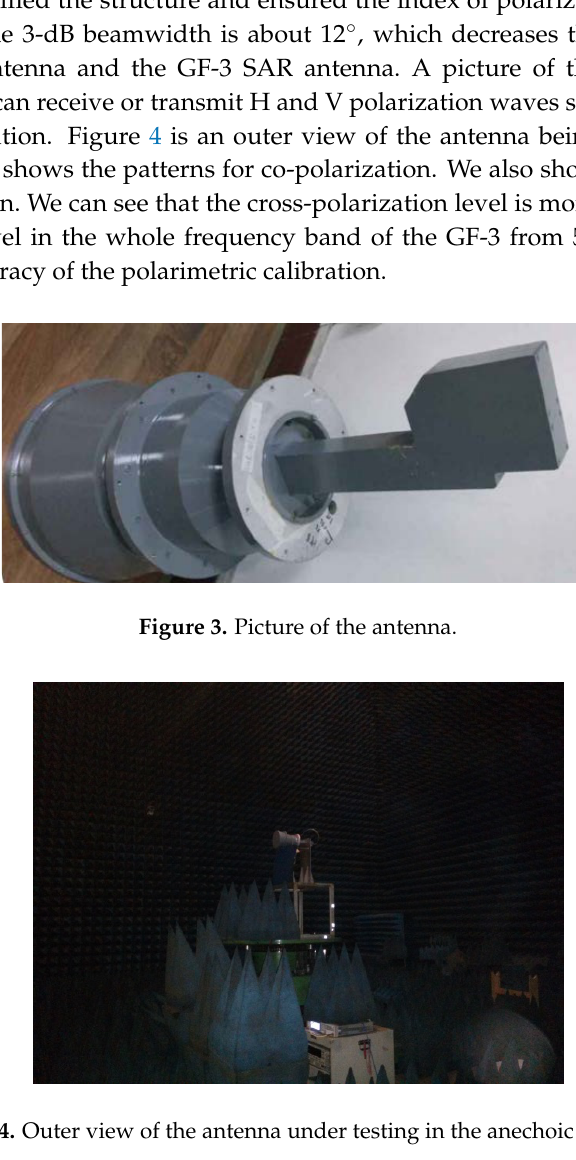
Table 1. Specifications of the polarimetric active radar calibrator (PARC).